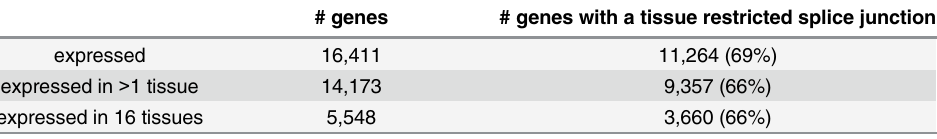
Table 2. Genes with tissue restricted splice junctions.